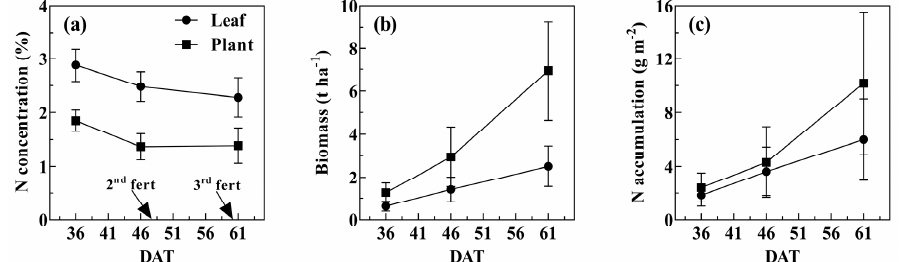
Figure 3. Average measurements of leaf or plant N concentration ( a ), biomass ( b ) and N accumulation